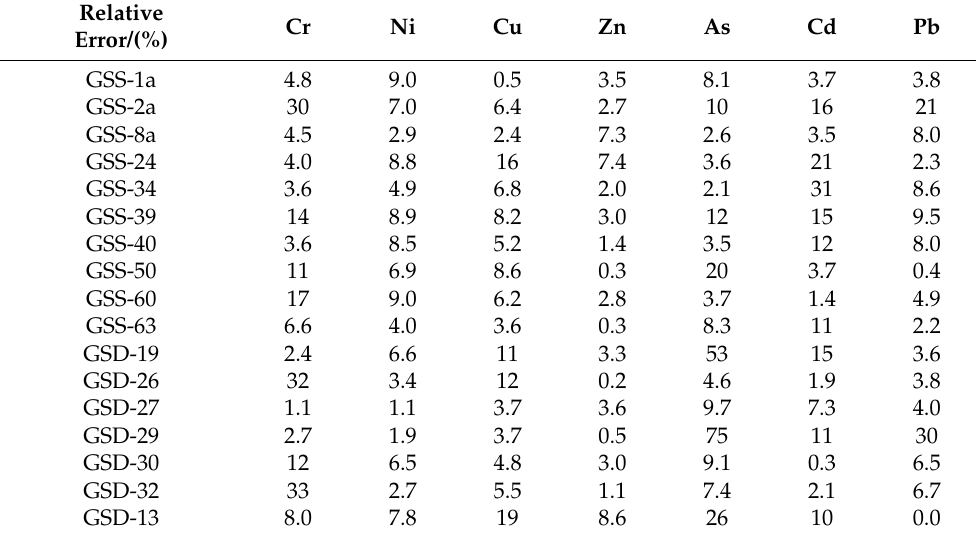
Table 3. The relative errors of the